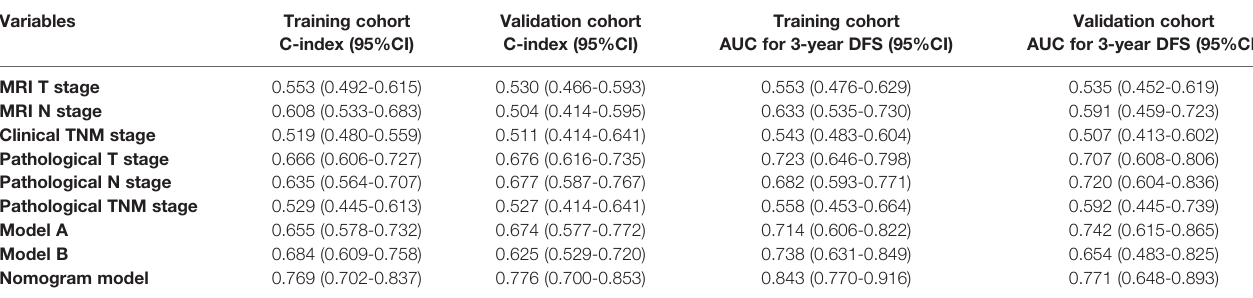
AUC, area under the curve. Model A: based on pathological T stage and N stage. Model B: based on pathological TNM stage and perineural